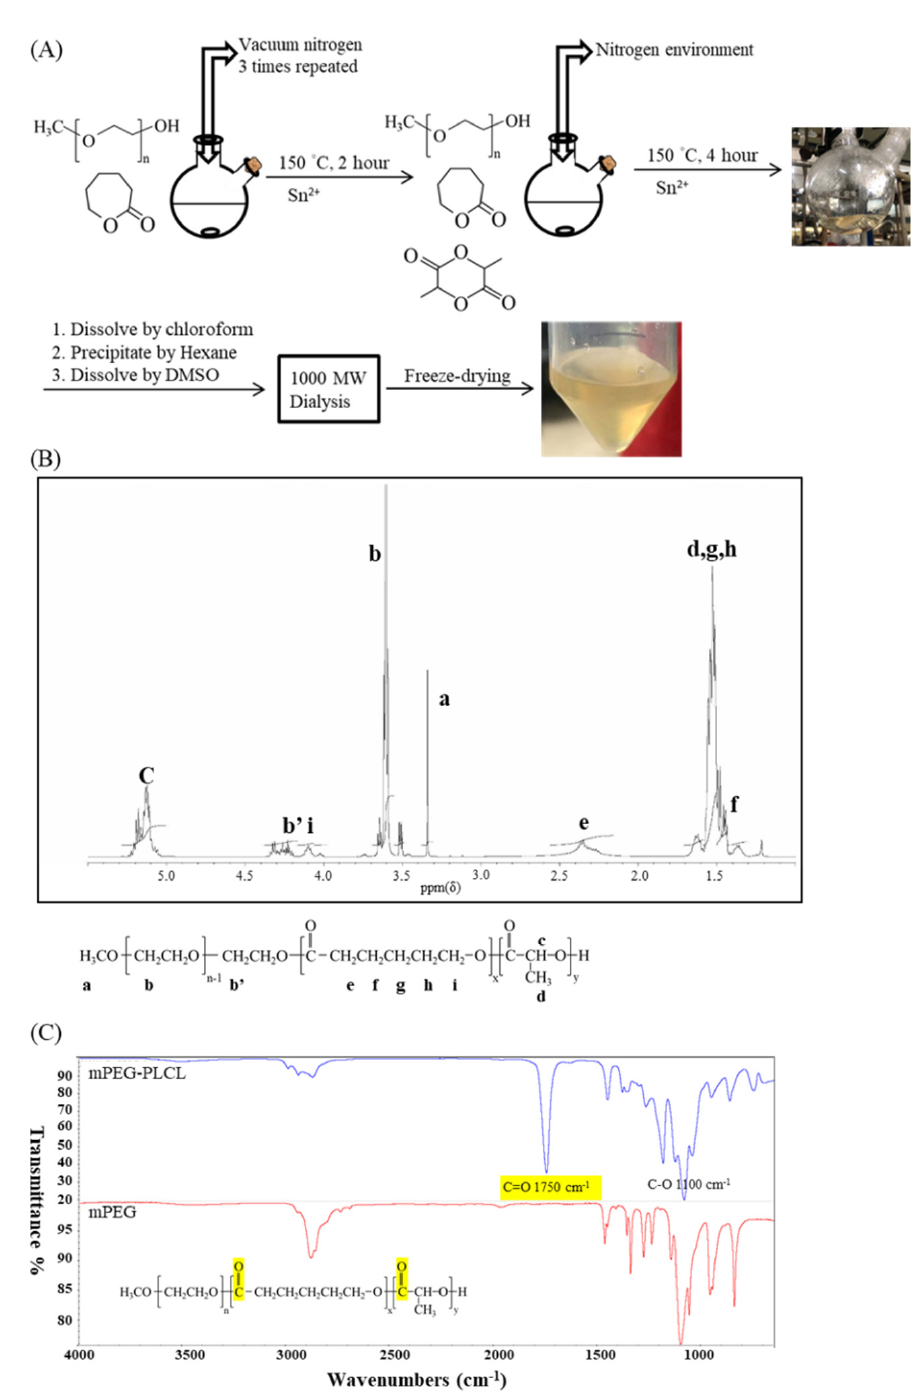
Figure 1. Synthesis and chemical properties of mPEG-PLCL. ( A ) Scheme of mPEG-PLCL synthesis. ( B ) 1H-NMR spectra. ( C ) FTIR spectra. The practical molecular weight was determined by the spectra of NMR in ( B ). n = 11, x = 2, y = 18. In ( C ), the highlighted part represents C=O bond signals. Table 1. Physical parameters of mPEG-PLCL.